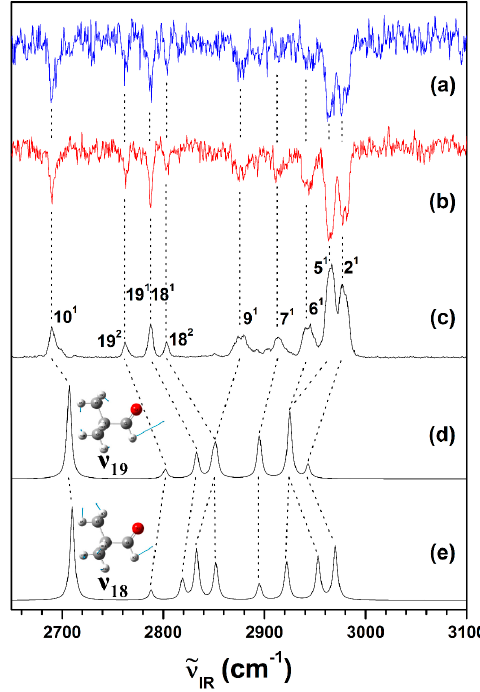
Figure 4. IR-dip VUV-MATI spectra of pivaldehyde were measured by monitoring intense peaks at ( a ) 76,629 and ( b ) 77,045 cm − 1 , respectively. ( c ) IR-resonant VUV-PI (76,529 cm − 1 ) spectrum of pivaldehyde measured by scanning IR laser. Simulated IR spectra for neutral pivaldehydes with 2O–1C–4C–5C dihedral angles of ( d ) 0° and ( e ) 2.1°, respectively, calculated at ω B97XD/cc-pVTZ level with anharmonic potentials.